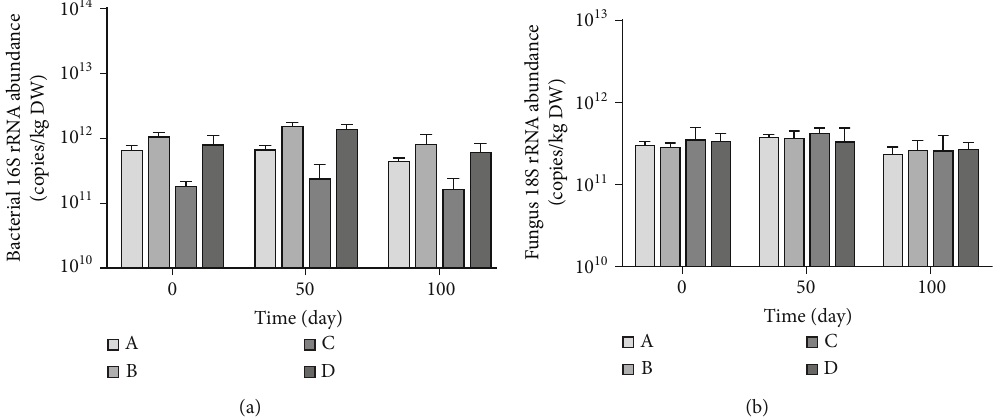
Figure 3: Bacterial 16S rRNA gene abundance (a), 18S rRNA gene abundance (b) for di ff erent treatments. Di ff erent letters above bars indicate signi fi cant di ff erences ( P < 0.05) at each sampling